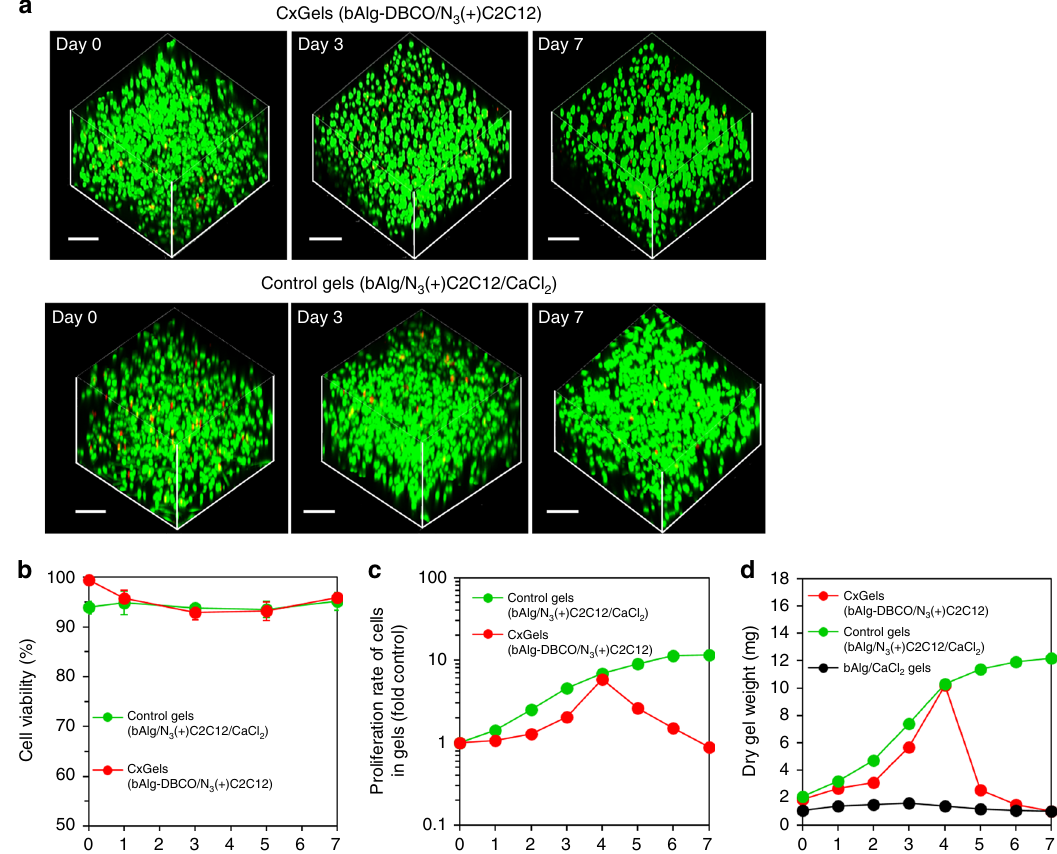
Fig. 3 Characterizations of the CxGels. a (upper) CLSM images of CxGels prepared through click reaction between azide-modi fi ed C2C12 cells (2.0× 10 6 cells) and bAlg-DBCO solution (2%) after live/dead assay. (lower) CLSM images of C2C12 cells-encapsulating control physical gels prepared through physical cross-linking reaction between bAlg solution (2%) and CaCl 2 solution (0.5%) in the presence of azide-modi fi ed C2C12 cells (2.0 × 10 6 cells) after live/dead assay. CLSM observation was carried out at days 0, 3 and 7 after CxGels preparation. Green fl uorescence indicates live cells stained with calcein- AM and red fl uorescence indicates dead cells stained with PI. Scale bars indicate 200 μ m. b Cell viability of C2C12 cells in the CxGels prepared through click reaction between azide-modi fi ed C2C12 cells (2.0 × 10 6 cells) and bAlg-DBCO solution (2%) and the cell-encapsulating control physical gels analyzed using the CLSM images after live/dead assay. Live/dead assay was performed at days 0, 1, 3, 5, and 7. Error bars: standard deviation ( n = 3). c Proliferation rates of C2C12 cells existing in the CxGels prepared through click reaction between azide-modi fi ed C2C12 cells (2.0 × 10 6 cells) and bAlg-DBCO solution (2%) and the control physical gels analyzed using the WST-1 assay. Error bars: standard deviation ( n = 3). d Time-dependent changes in the dry CxGels